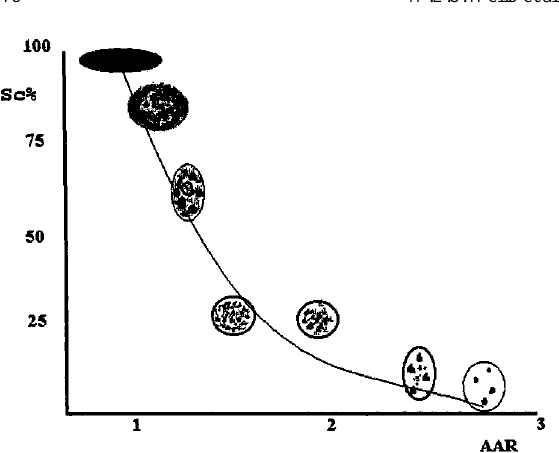
Fig. 8. Representation of positions assumed in the AAR (average ab- sorption ratio, see text) vs. Sc% (condensed chromatin area) scatter diagram by nuclear phenotypes differing in chromatin